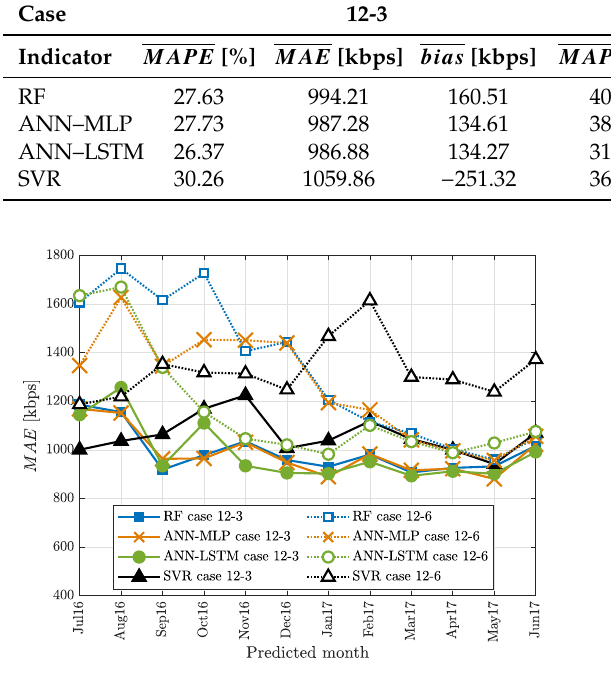
Figure 4. 𝑀𝐴𝐸 time